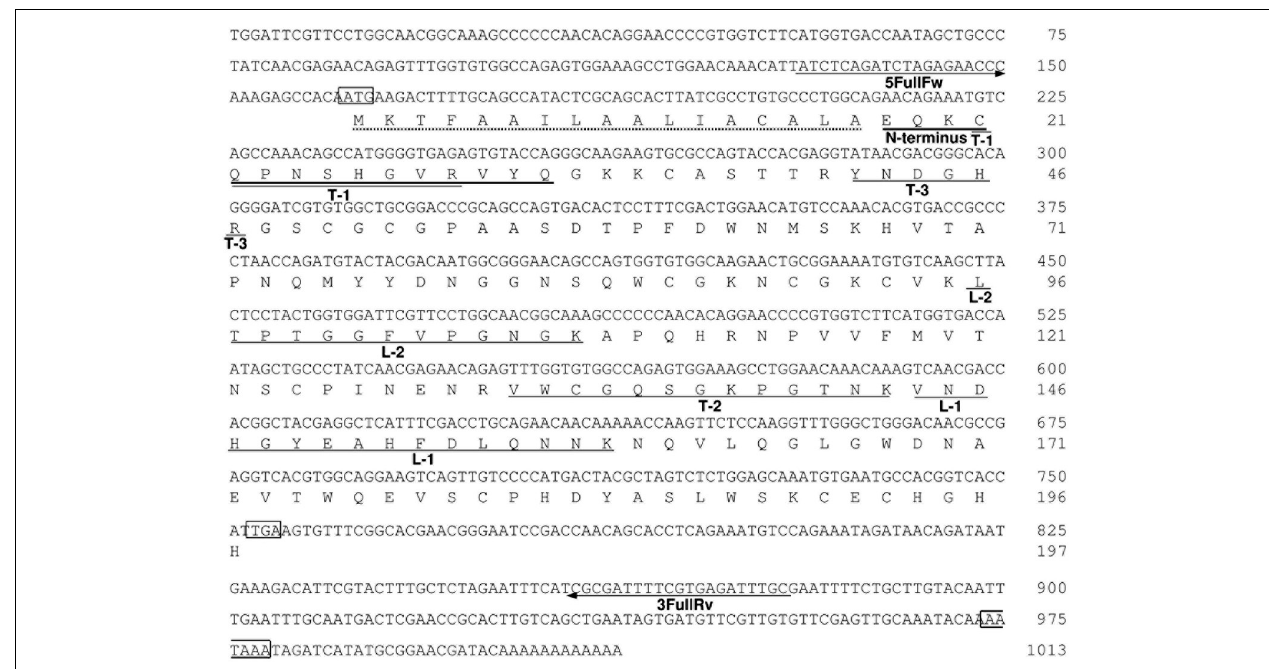
FIGURE 5 | The nucleotide and deduced amino-acid sequences of AkEG21. Residue numbers for nucleotides and amino-acids are indicated in the right of each row. The translational initiation codon ATG, termination codon TGA, and a putative polyadenylation signal AATAAA are boxed. A putative signal peptide is indicated by a dotted underline. The amino-acid